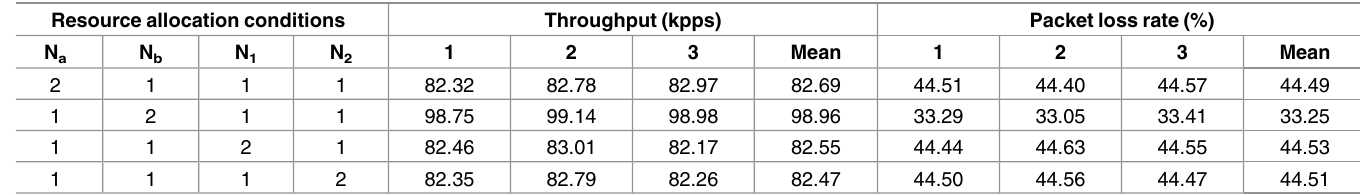
Table 2. Test results of Experiment